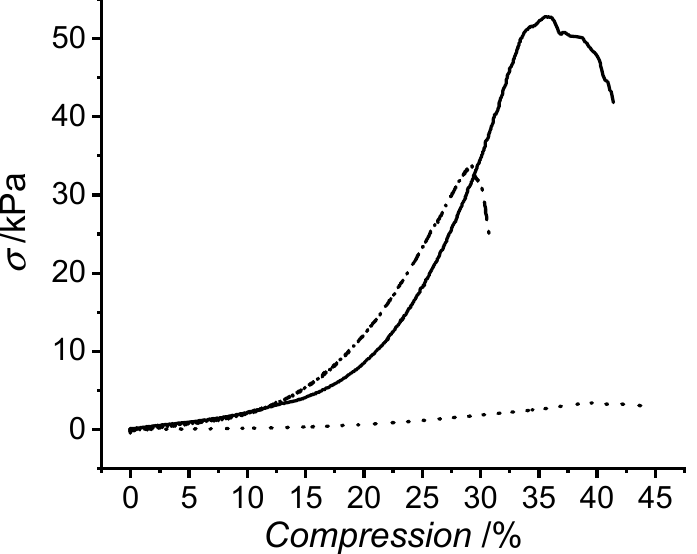
Figure 5. Typical stress–compression curves of UV-cured hydrogels: B-4VBC* (black dash dot), R-4VBC* (black solid), and P-4VBC* (black dot).